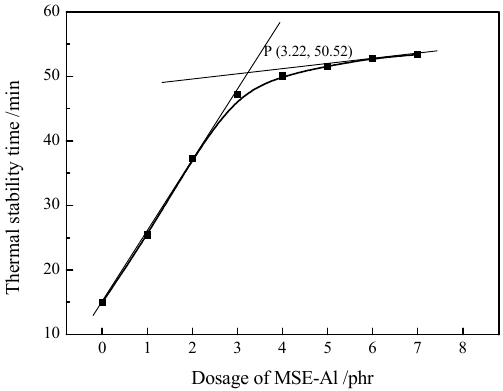
Figure 3. Thermal stability time of the PVC samples stabilized with different amounts of MSE-Al.